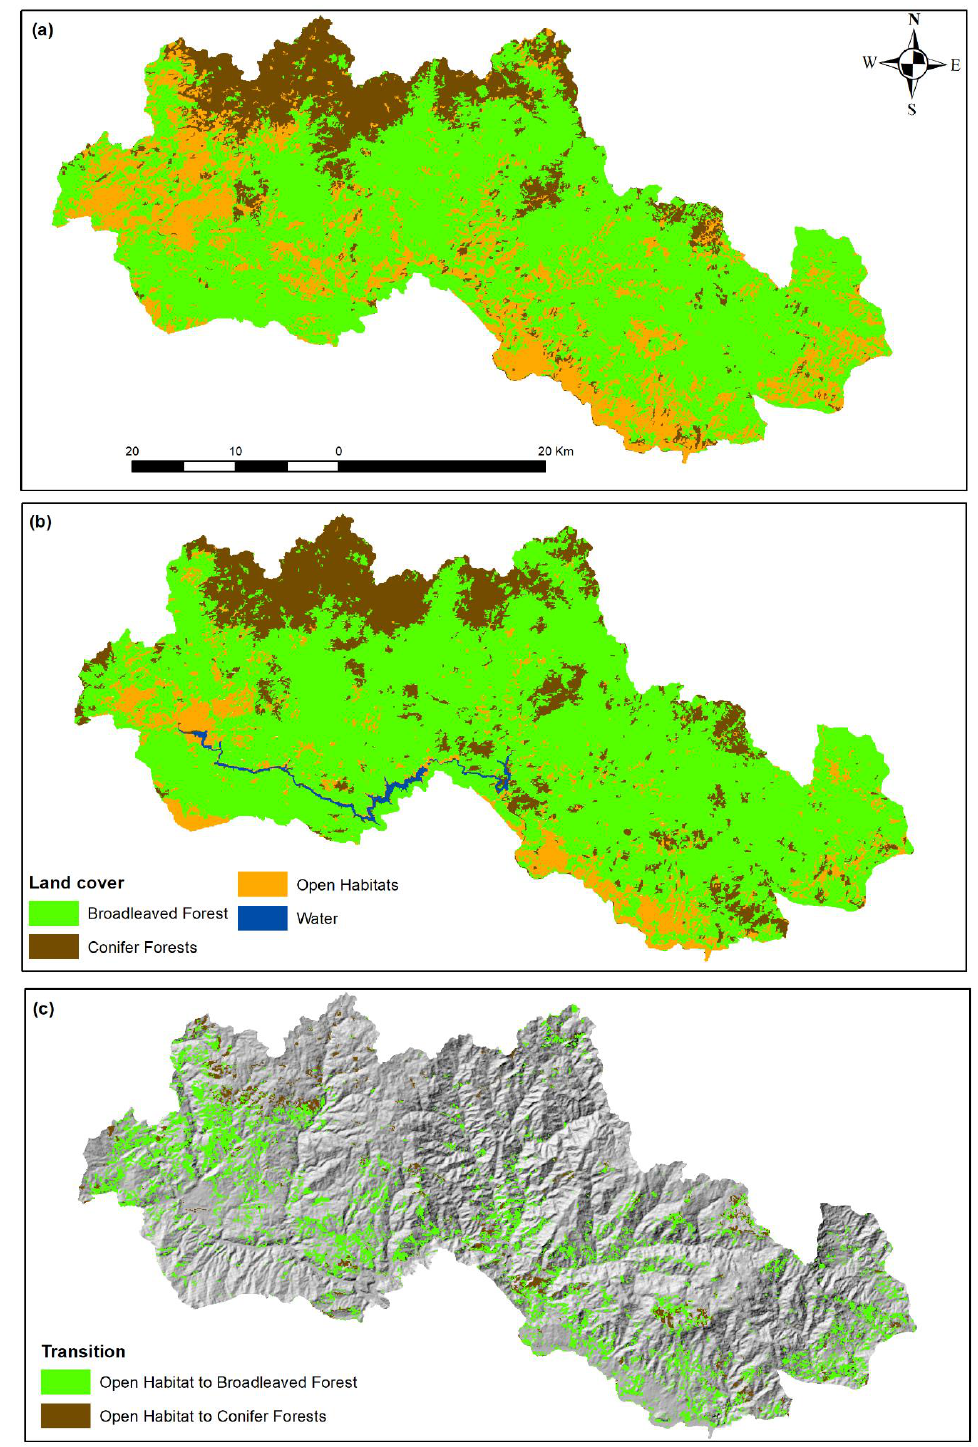
Figure 4. Landcover maps of the years 1984 ( a ) and 2019 ( b ) and transition map from open habitats to broadleaved or conifer forests ( c ).